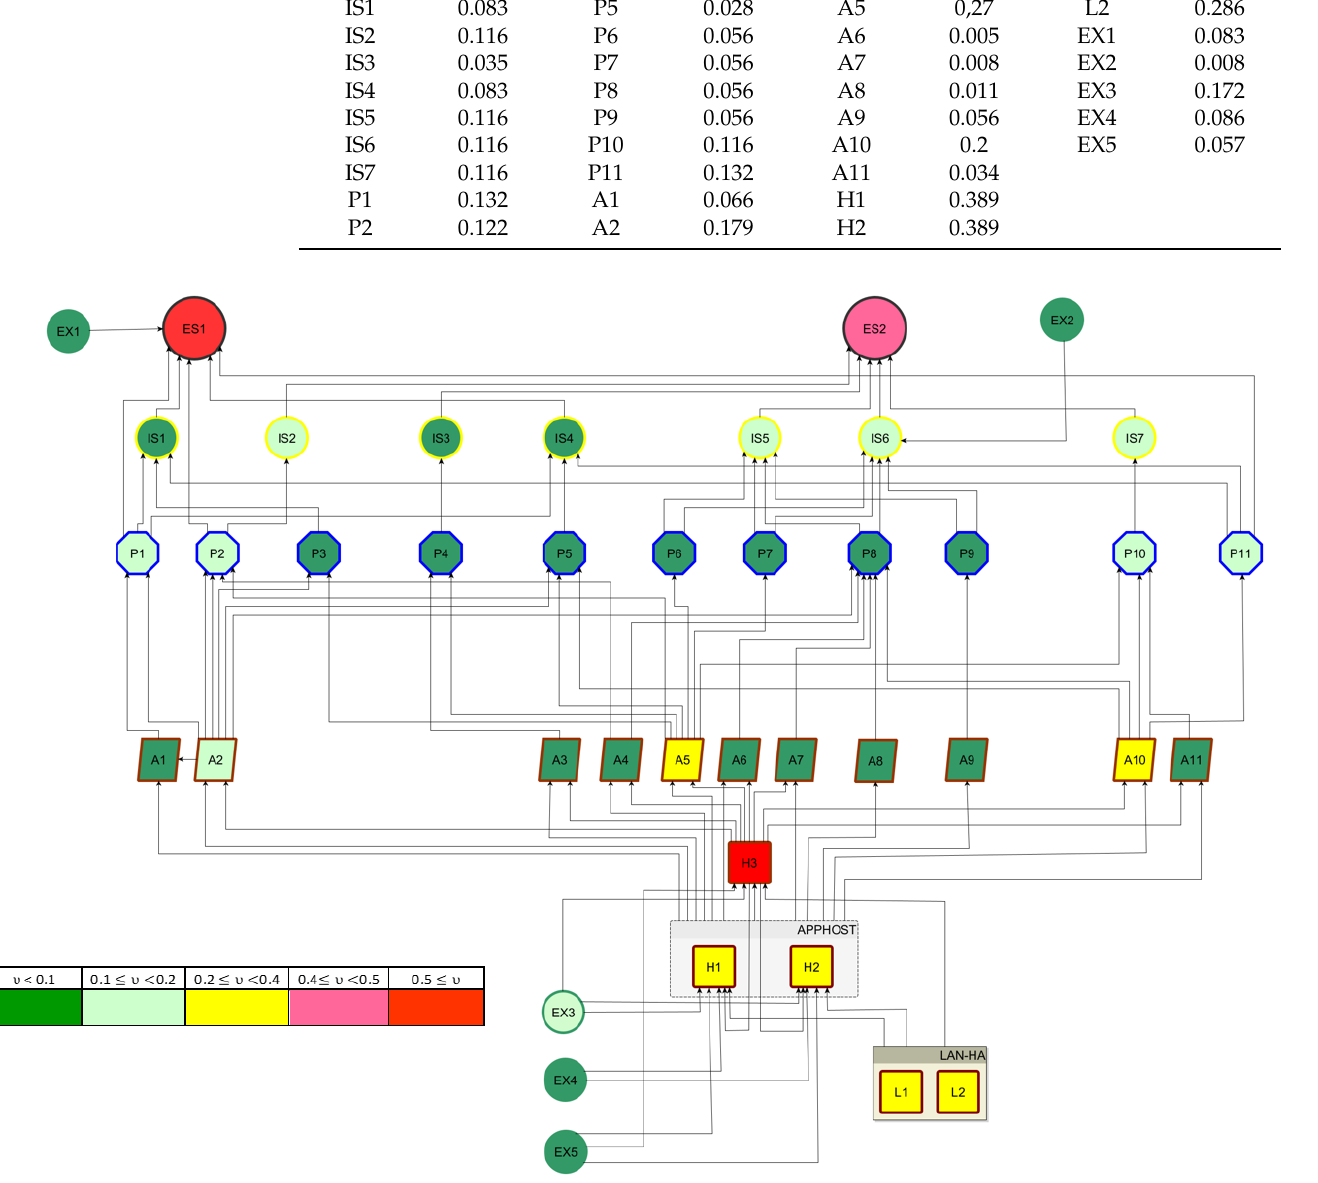
Figure 8. Visualizing the business criticality of